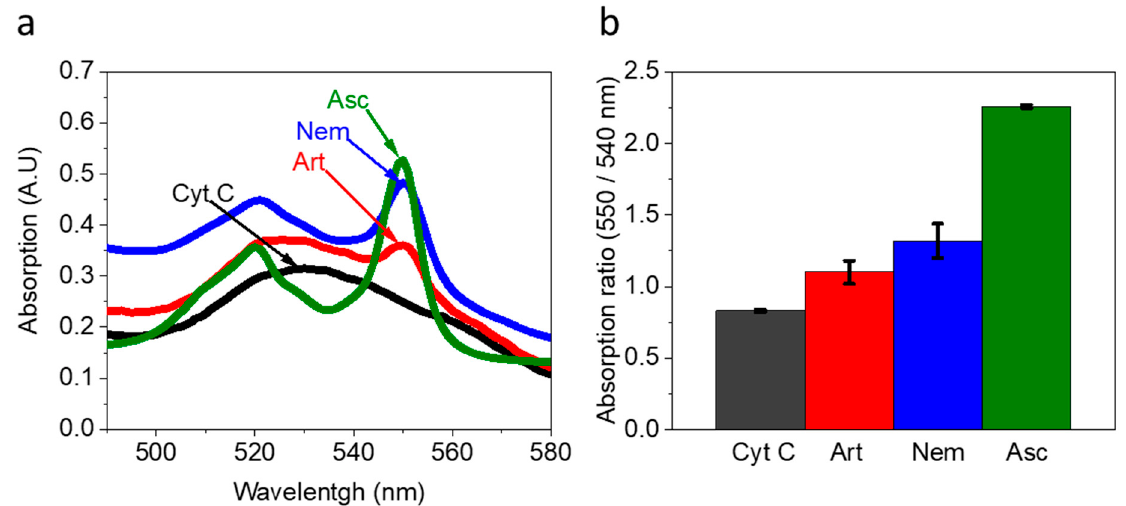
Figure 2. Artemia ’s eggs and Nematostella secrete components that reduce Cyt C. Artemia ’s eggs, and a Nematostella unit were incubated in a pure buffer for 1 h. The external solution (without the organisms) was incubated with 30 µ M Cyt C for 1 h. ( a ) Absorption spectra of Cyt C (black) and Cyt C exposed to the external solution of Artemia ’s eggs (Art, red), Cyt C exposed to the external solution of Nematostella (Nem, blue), and Cyt C fully reduced by Ascorbic Acid (Asc, green). ( b ) Absorption ratio 550/540 nm of Cyt C (black) and Cyt C exposed to the external solution of Artemia ’s eggs (Art, red), Cyt C exposed to the external solution of Nematostella (Nem, blue), and Cyt C fully reduced by Ascorbic Acid (Asc, green). The error bars represent the standard deviation over three independent repetitions.